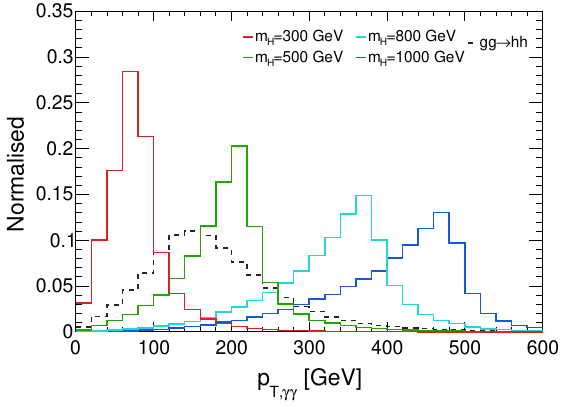
Figure 5 . The m and p T;(cid:13)(cid:13) distributions for heavy Higgs masses of m H = 400 and 600 GeV with b (cid:22) b(cid:13)(cid:13) backgrounds. Here the heavy Higgs boson is searched for in the bb(cid:13)(cid:13) (cid:12)nal state. The distributions are shown after imposing the (cid:12)xed cuts.